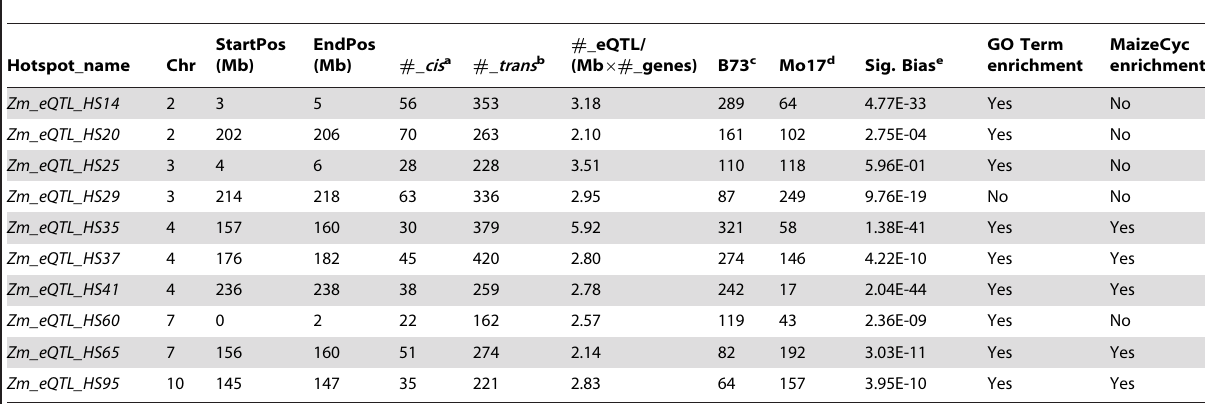
a,b Indicates the number of cis- and trans- eQTLs in each eQTL hotspot, respectively. c Indicates the number of eQTLs, where the B73 allele increased the expression level in the RIL population. d Indicates the number of eQTLs, where the Mo17 allele increased the expression level in the RIL population. e Shows the significance level deviating from the random distribution between B73 and Mo17. The GO enrichments and the pathway enrichments of the regulated genes by hotspots were conducted using BiNGO plugin in Cytoscape based on the annotation information from AgriGO and MaizeCyc database, respectively. The results of GO enrichments and pathway enrichments are in Table S5 and Table S6,